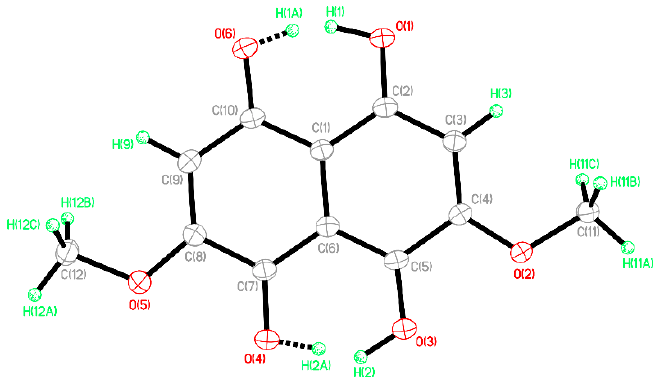
Figure 4. Chemical structure of Dramada obtained with X-ray diffraction (XRD).